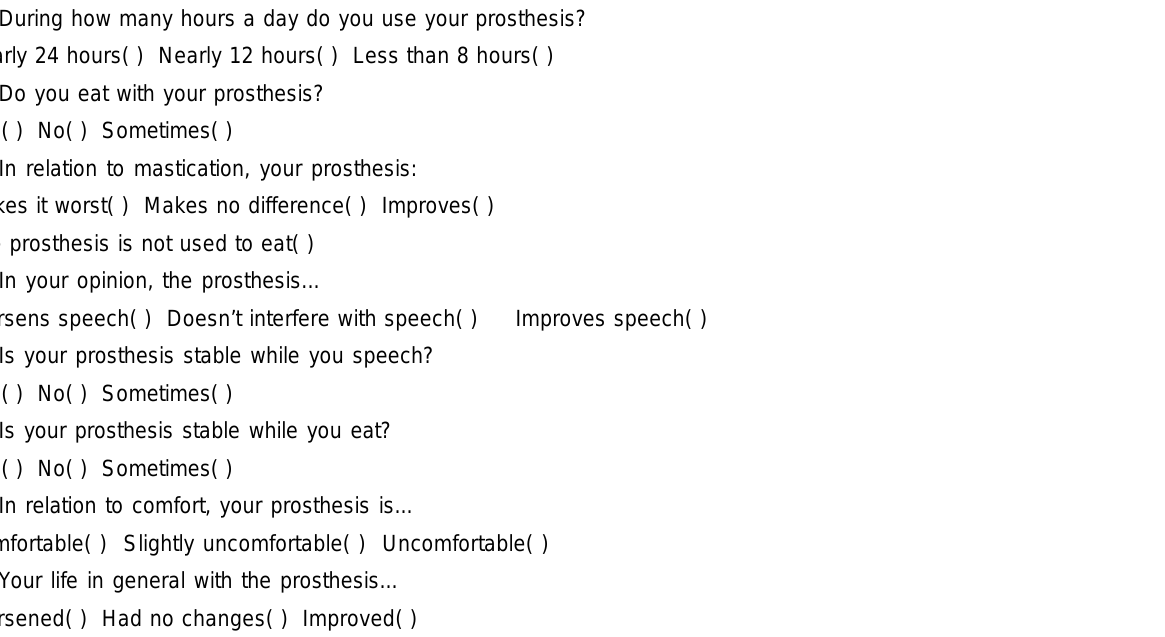
TABLE 1- Questionnaire applied to velopharyngeal dysfunction patients treated with a palatal